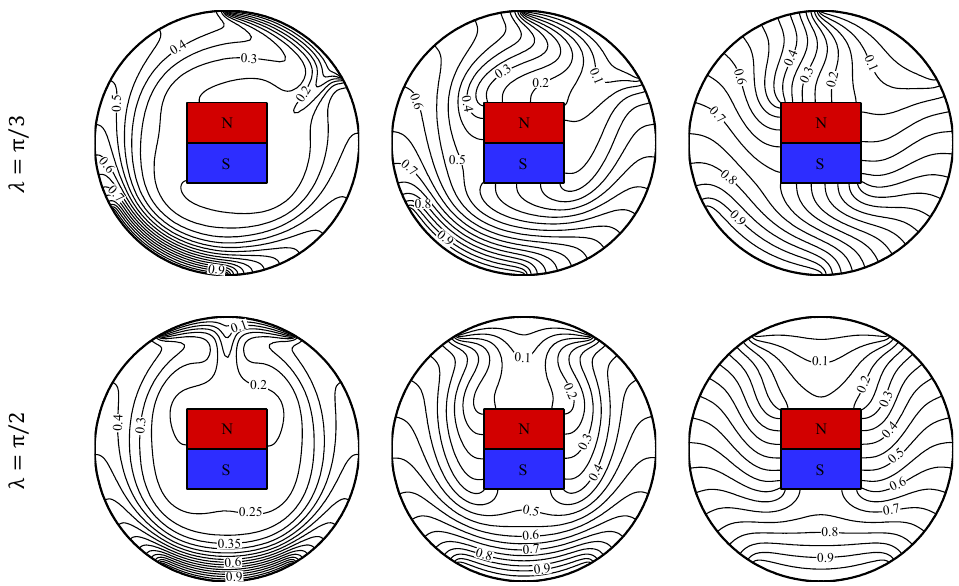
Figure 5. Dependence of the isotherms on the power law index, n , and angle of the hot and cold arcs relative to the horizontal, λ , when Ra T = 10 4 , Ra M = 10 7 , Pr = 100, Ma = 10 − 4 , β c = 60, δ = 30 ◦ and L = 0.3.